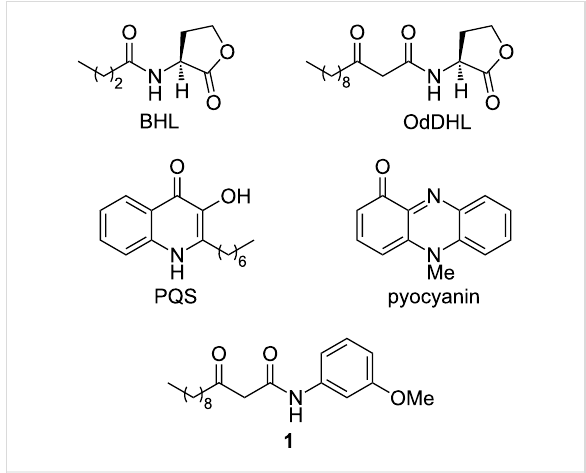
Figure 1: BHL and OdDHL are two natural AHL-based signaling mole- cules used by P. aeruginosa in quorum sensing. PQS is a natural quinolone signaling molecule also used by P. aeruginosa in quorum sensing. Pyocyanin is a P. aeruginosa virulence factor. Compound 1 is an abiotic OdDHL-mimic which can inhibit pyocyanin production [8,9].